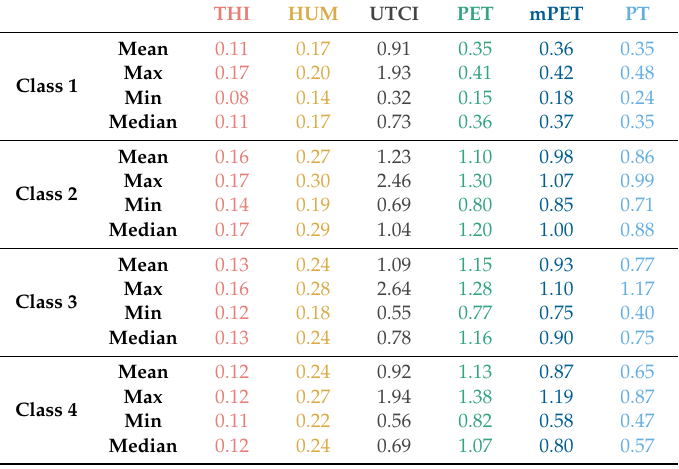
Table 7. Descriptive statistics of the indices’ sensitivity to Vapour Pressure (VP) under different Global Radiation (GR) conditions.